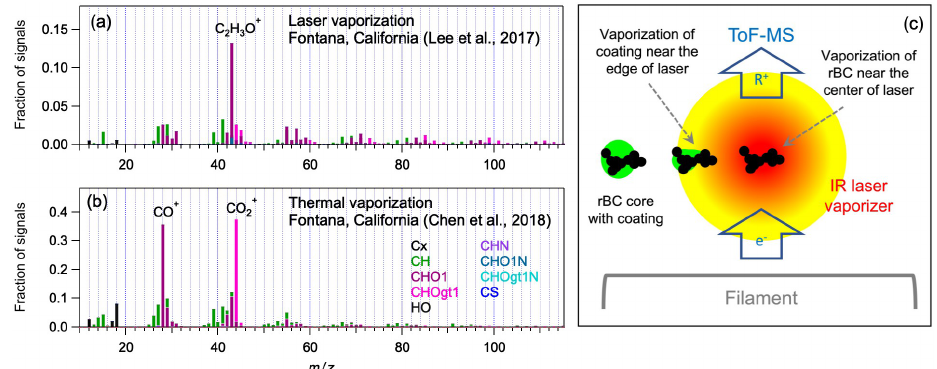
Figure 1. Mass spectra of more-oxidized OOA materials measured in Fontana, California, using the (a) laser and (b) thermal vaporization schemes. (c) A simplified diagram of the laser vaporizer scheme in the SP-AMS. The laser intensity is stronger at the center, in which rBC can be completely vaporized at ∼ 4000K. Organic coatings start to vaporize at the edge of laser beam during the heating process of